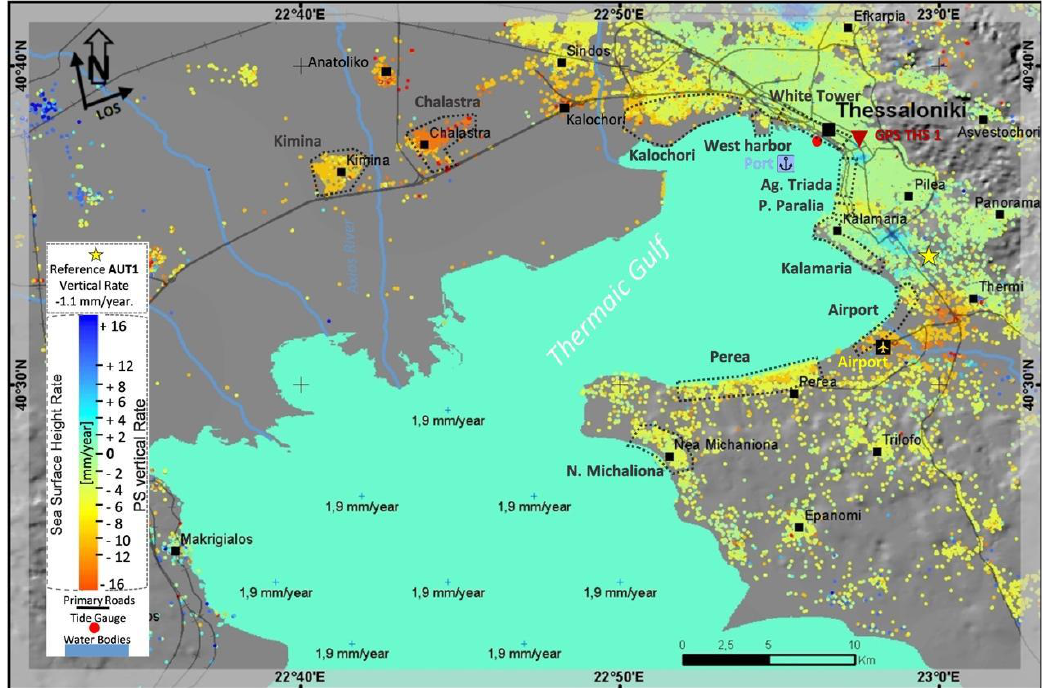
Figure 5. Vertical land deformation rate and sea-surface height rate map of Thermaic Gulf coastal zone; City of Thessaloniki, Axios Delta. The studied sub-areas are bounded with black dashed lines. The Global Navigation Satellite System THS1 station and tide gauge, respectively, used in validation are depicted with a reversed red triangle and a red circle. PS stands for permanent scatterers The PSMSL tide gauge located in the harbor (red circle in Figure 5) measures a relative sea level trend of 3.83 ± 0.66 mm/year (with a 95% confidence) based on a monthly mean sea level data from